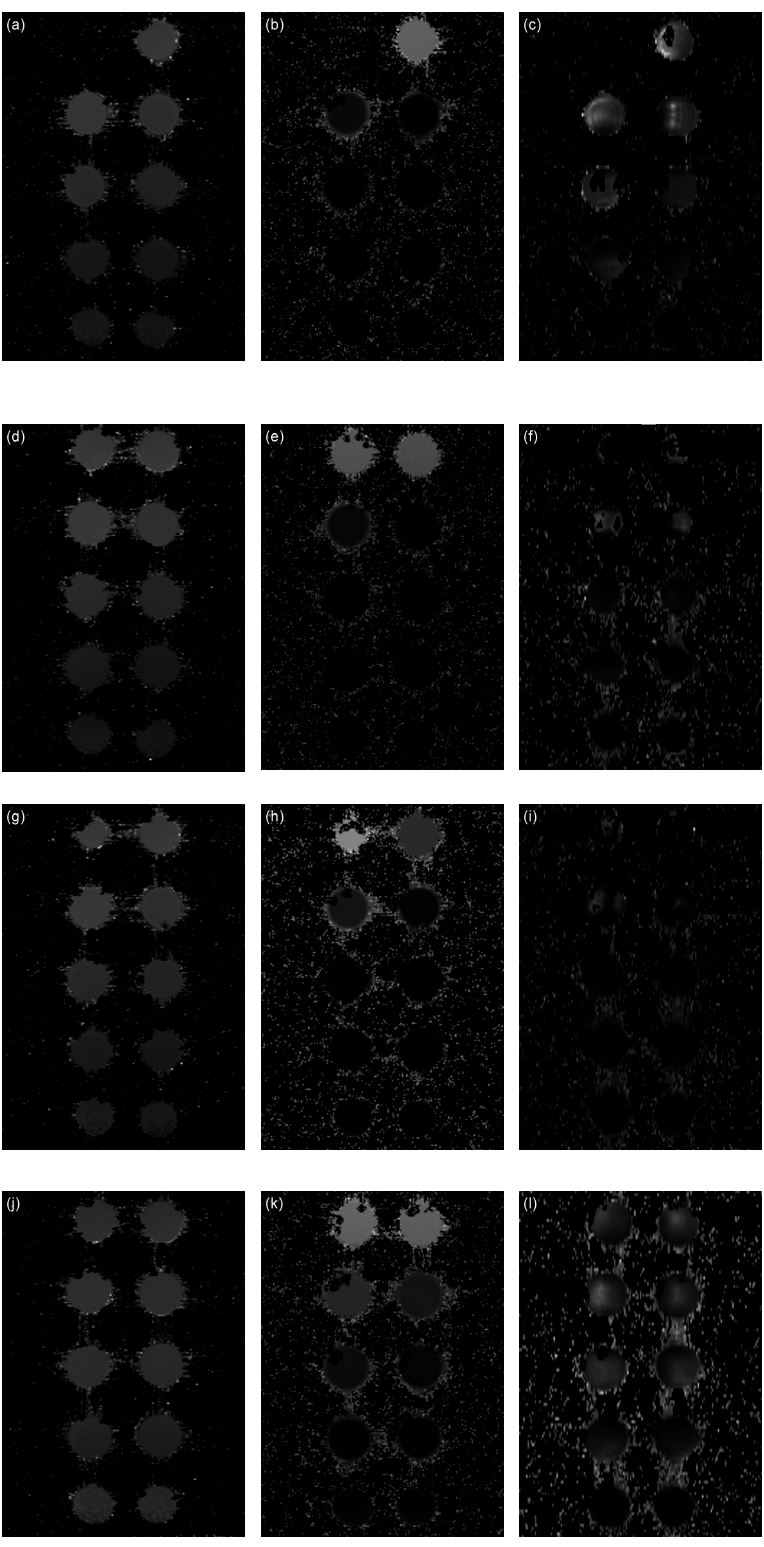
Figure 9. Relaxation time maps of the AA–MNP complexes. ( a ) MNPs T 1 map, ( b ) MNPs T 2 map, ( c ) MNPs T 2 * map, ( d ) Lys-MNPs T 1 map, (e) Lys-MNPs T 2 map, ( f ) Lys-MNPs T 2 * map, ( g ) Gly-MNPs T 1 map, ( h ) Gly -MNPs T 2 map, ( i ) Gly -MNPs T 2 * map, ( j ) Trp-MNPs T 1 map, ( k ) Trp -MNPs T 2 map, ( l ) Trp -MNPs T 2 * map.